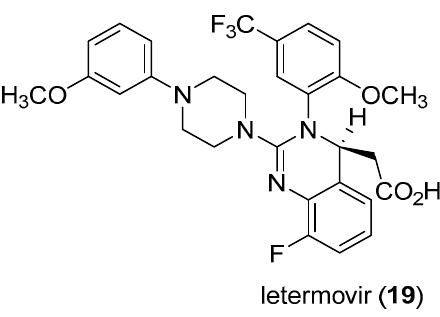
Figure 3. PREVYMIS™ (letermovir) a recently (2017) FDA-approved drug for the prevention of Human cytomegalovirus (HCMV) infection and disease in organ transplant